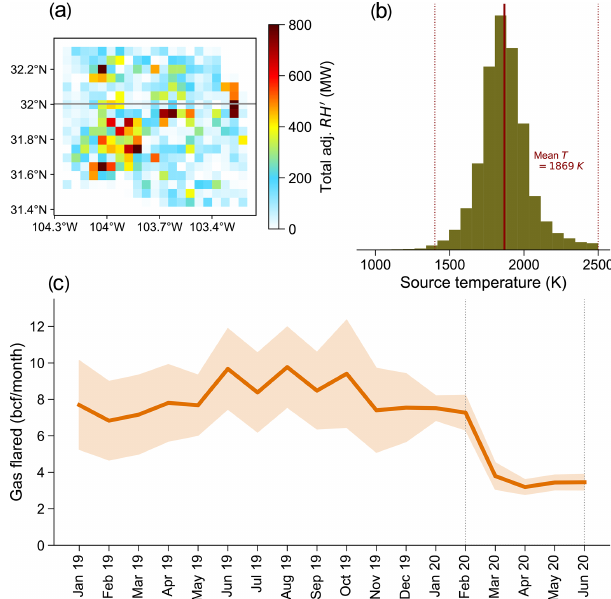
Figure 8. VIIRS-derived gas flaring in the study region. (a) Spa- tial distribution of the cumulative adjusted radiant heat over the period between January 2019 and June 2020 aggregated over a 0.05 ◦ × 0.05 ◦ grid resolution. (b) Histogram of VIIRS-derived source temperatures. Dotted lines show the temperature regime characteristic of gas flaring sources (1400—2500K). (c) Monthly trend in VIIRS-derived gas flared volumes. The mean estimate is shown with a solid line, and the 95% CI on the mean is shown in the shaded area. 1 billion cubic feet (Bcf) = 2 . 8 × 10 7 m